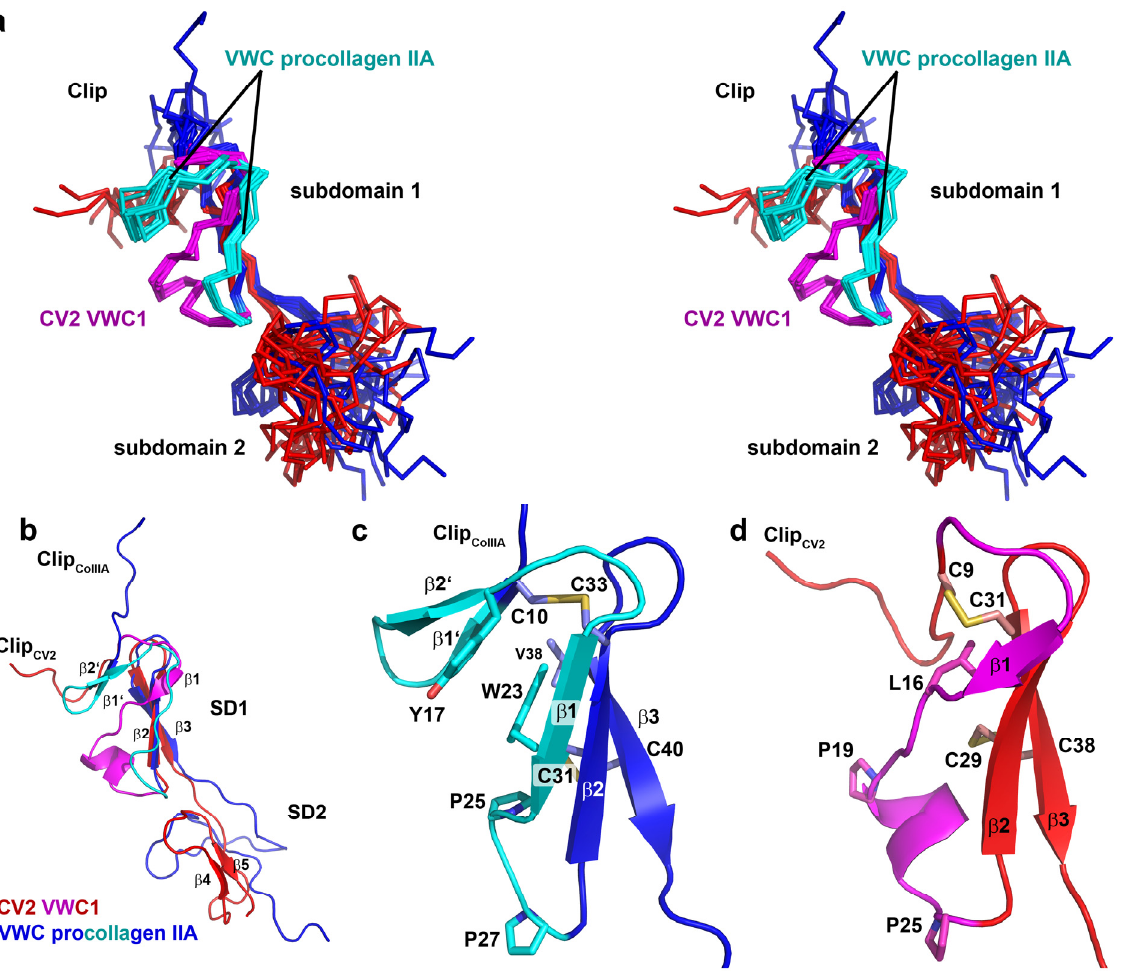
Figure 4. ( a ) Stereoview of a superposition for the structure ensembles (10 structures each) of CV2 VWC1 (red, differing elements in magenta) and procollagen IIA VWC (blue, differing elements colored in cyan). ( b ) Ribbon plot of CV2 VWC1 structurally aligned to the VWC domain of procollagen IIA. ( c ) Magnification of the VWC subdomain 1 of procollagen IIA highlighting the additional two-stranded β -sheet 1' and 2' which are possibly formed (and stabilized) due to hydrophobic interaction between residues in the β -strands β 1' and β 2' and β 1. ( d ) Magnification as in ( c ) but for the VWC1 domain of CV2. At the C-terminal side of the first cysteine the loop adopts a turn-like structure with a short β -strand 1 and merging into a one-turn helix. One clear difference is in the length of the peptide sequence interspersed between the two conserved proline residues (P25 and P27 in VWC procollagen IIA and P19 and P25 in CV2